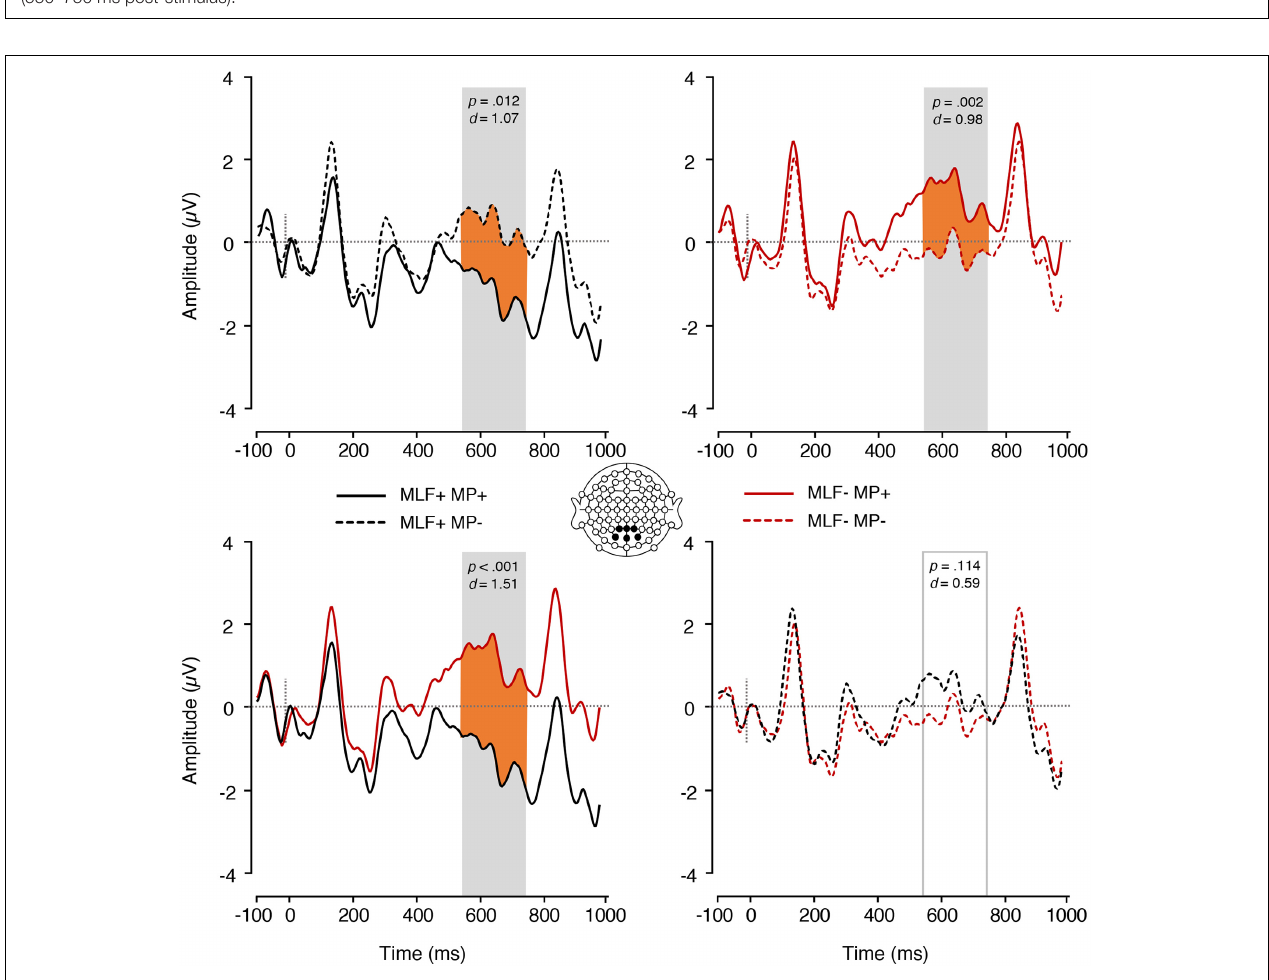
FIGURE 5 | ERPs elicited by adjectives preceded by nouns. Left , in the MP+ and MP– conditions (main effect of MP). Right , in the MLF+ and MLF– conditions (main effect of MLF). The plain grey box indicates the time window of the analysis in which mean ERP amplitudes significantly differed between conditions (550–750 ms post-stimulus).